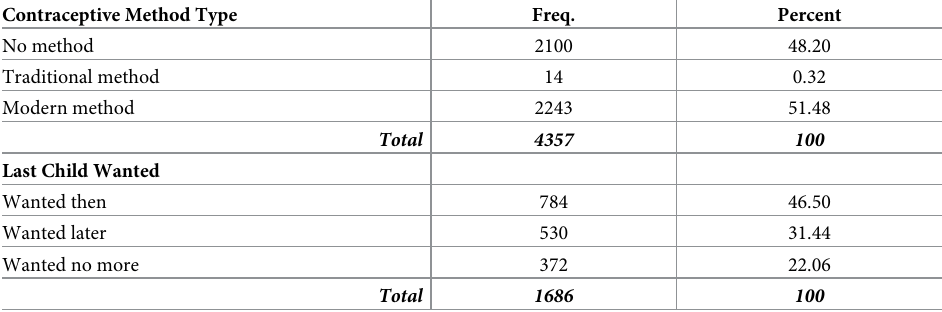
Table 3. Percentage and frequency distributions of South African women of reproductive age by “child wanted- ness” factors.